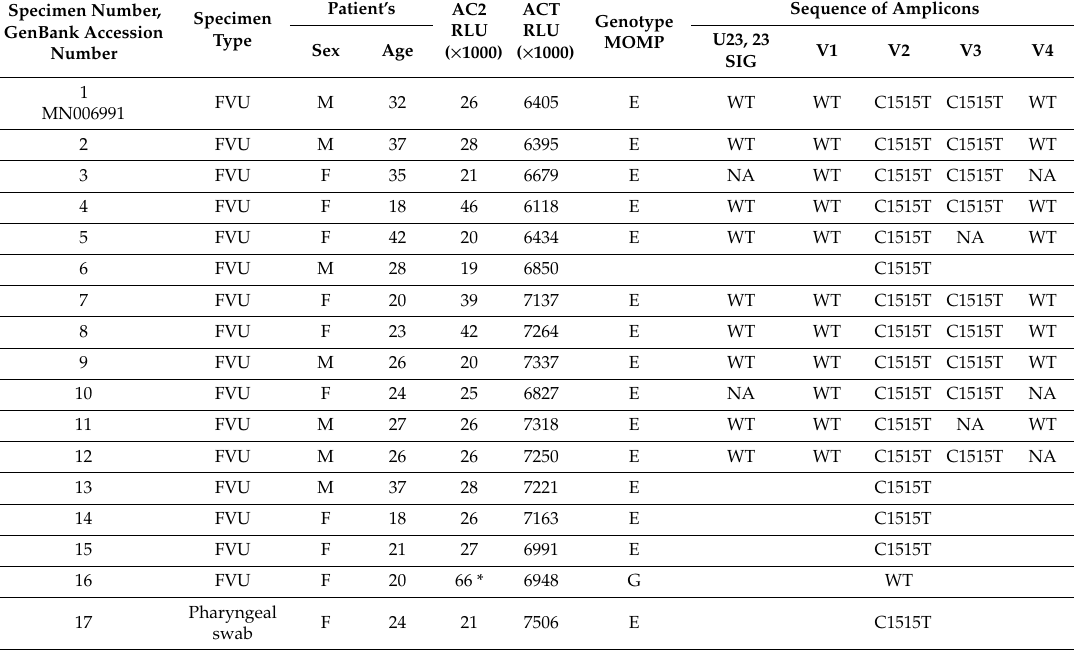
Table 2. Characteristics of specimens with negative / equivocal * Aptima Combo 2 and positive Aptima Chlamydia trachomatis